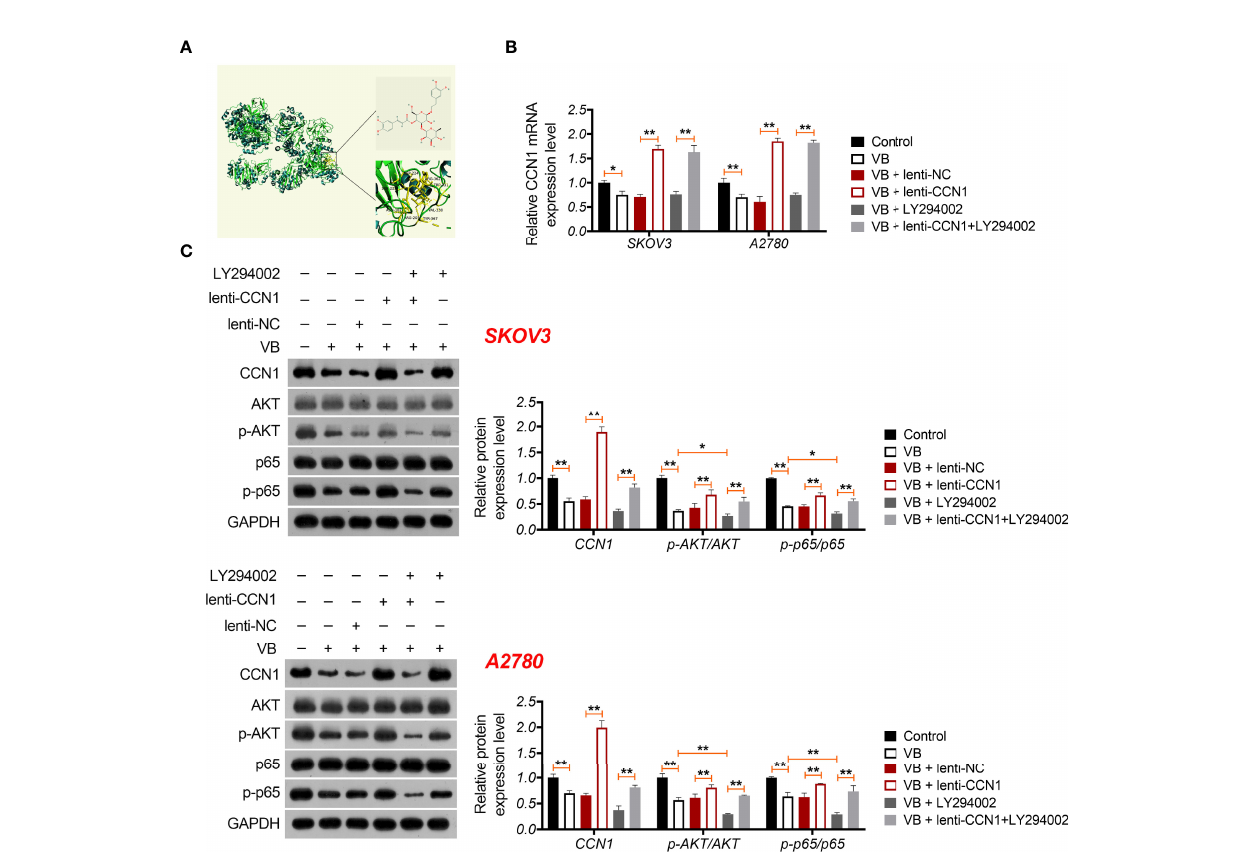
FIGURE 3 | VB interacts with CCN1 and inhibits CCN1-mediated AKT/NF- k B pathway. (A) Molecular docking of VB and CCN1. (B) The relative mRNA expression of CCN1 was determined by RT-qPCR. (C) The protein expression levels of CCN1, AKT, p-AKT, p65, and p-p65 were detected by western blotting in A2780 and SKOV3 cells. Each treatment was replicated three times. Error bars represent the mean ± SD; * P < 0.05 and ** P <